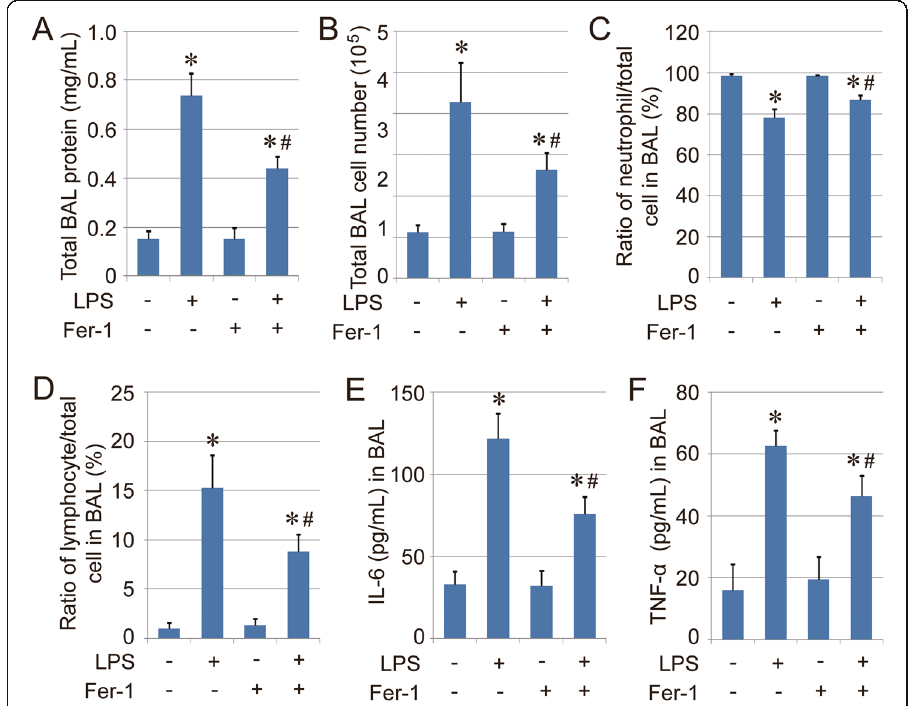
Fig. 5 BAL assay. a . Total protein concentration in BAL fluid from each group. b . Total BAL cell numbers in each. c - d . Percentage of BAL neutrophils and BAL lymphocytes in different groups. e - f . Concentration of IL- 6 and TNF- α in each group. Results are expressed as means±SEM ( n = 4). *: p < 0.05 compared with the control group. #: p < 0.05 compared with the LPS